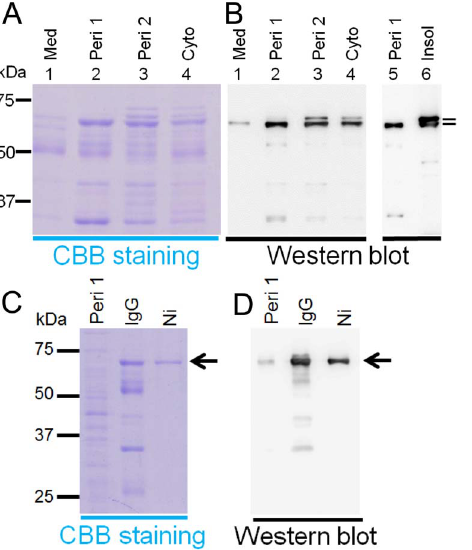
Figure 2. Analysis of localization of E. coli -produced fusion proteins. (A) 10% SDS-PAGE analysis of the recombinant proteins from the culture medium (Med), periplasmic fractions (Peri 1 and Peri 2) and cytoplasmic soluble fraction (Cyto) and the insoluble fraction (Insol) from E. coli . The proteins in the gel were visualized by staining with Coomassie Blue R-250. (B) Western blot analysis of the recombinant proteins. Proteins were run on SDS-PAGE and transferred to PVDF membrane. Western blots were probed with an anti-V5-HRP antibody. Approximately 2 m g of each protein was electrophoresed. The molecular mass (kDa) of the molecular weight markers (All Blue, Bio- Rad) are shown in the left margin, and the positions of the fusion proteins (Protein A-AMCase-V5-His) are shown with arrows in the right margin. (C and D) Purification of the recombinant proteins. The fusion proteins were expressed in E. coli and purified from the periplasmic fraction 1 (Peri 1) by IgG Sepharose followed by Ni Sepharose. Proteins separated by SDS-PAGE were stained with Coomassie Blue R-250 (C) or transferred to PVDF membrane (D). Western blots were probed with an Anti-V5-HRP